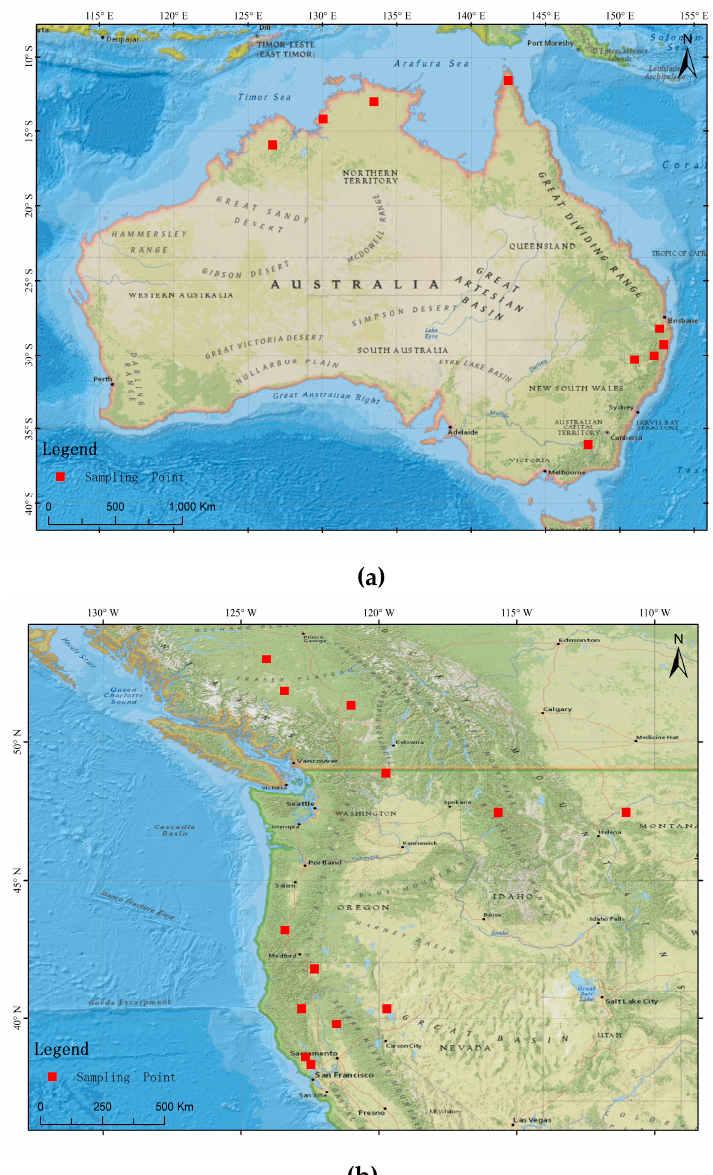
Figure 4. Schematic map of the study area: ( a ) Australia, and ( b ) the west coast of the United States and Canada.